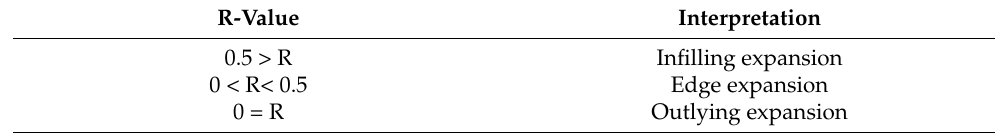
Table 6. Interpretation of the